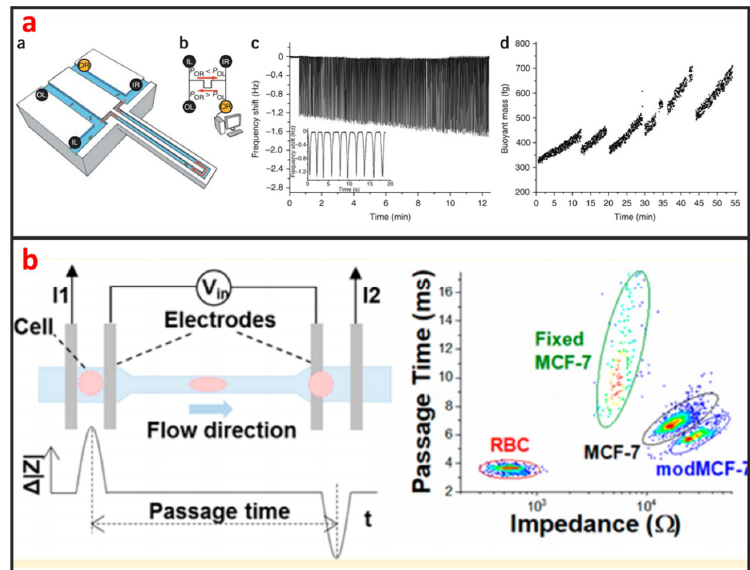
Figure 11. Biophysical property analysis of single-cells by using microfluidics. ( a ) A dynamic fluidic control system that enables the buoyant mass of cells as small as bacteria and as large as mammalian lymphocytes to be repeatedly measured with a suspended microchannel resonator (SMR). Adapted by permission from Reference [119], copyright Nature Publishing Group 2010. ( b ) A microfluidic